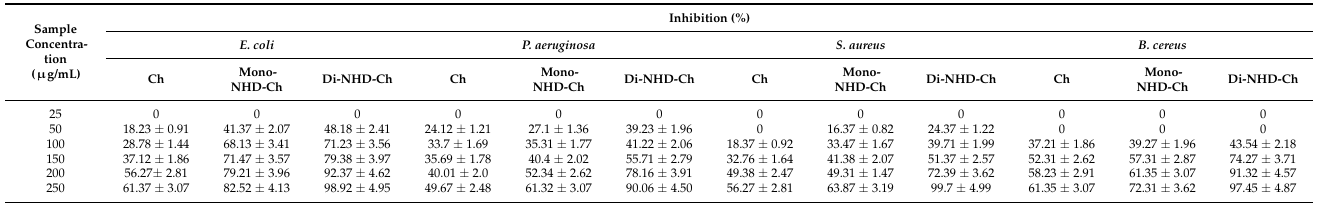
Table 3. MIC of chitosan and its alkyl derivatives (Mono-NHD-Ch and Di-NHD-Ch). (The data are the mean of three determinations. First, ± is standard deviation